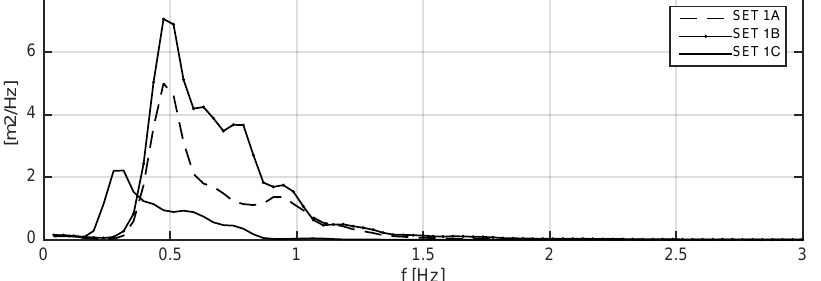
Figure 9. Energy spectra of the three different wave conditions which are summarized in Table 3. All model configurations and results are pre-decisional and for official use only.